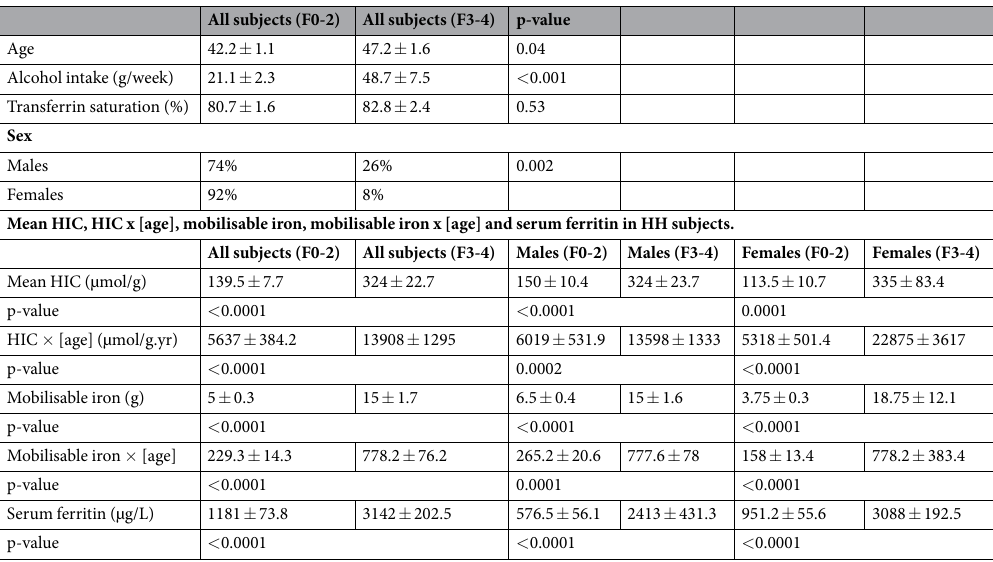
Table 2. Mean age, alcohol intake, transferrin saturation and sex in HH subjects. Advanced fibrosis = F3-F4 fibrosis, No advanced fibrosis = F0-F2 fibrosis. Data presented as mean ± standard error of mean or proportions. HIC, hepatic iron